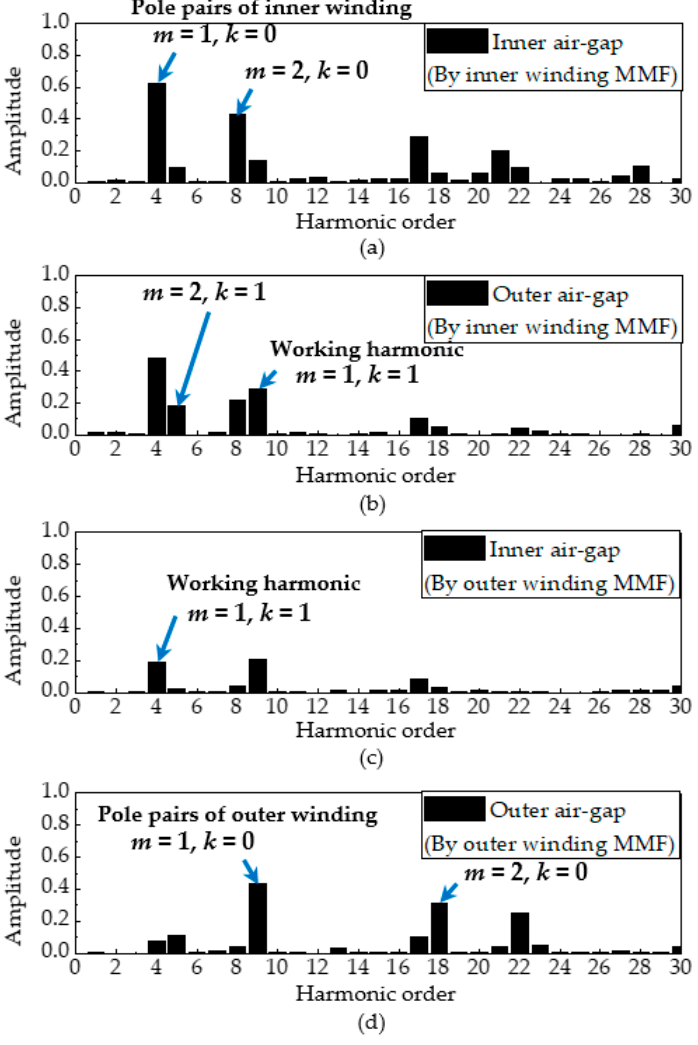
Figure 3. Space harmonic spectra of the modulated flux density produced by the winding MMF: ( a ) Inner air-gap (by inner winding MMF); ( b ) Outer air-gap (by inner winding MMF); ( c ) Inner air-gap (by outer winding MMF); ( d ) Outer air-gap (by outer winding MMF).